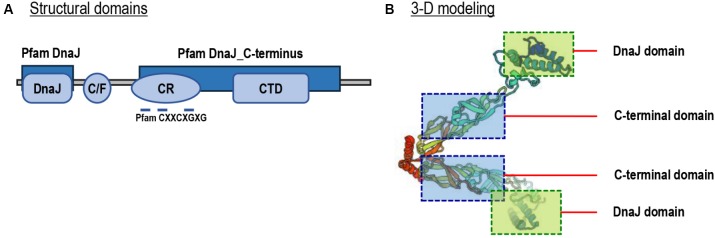
(A) Structural domains of Lv-HSP40 predicted by the SMART and ScanProsite programs. The J, G/F, C/R, and CT domains are boxed, and the CXXCXGXG motifs are indicated. (B) Three-dimensional (3-D) protein model for a Lv-HSP40 dimer by the SWISS-MODEL server. The J domains and CT domains are boxed and indicated.